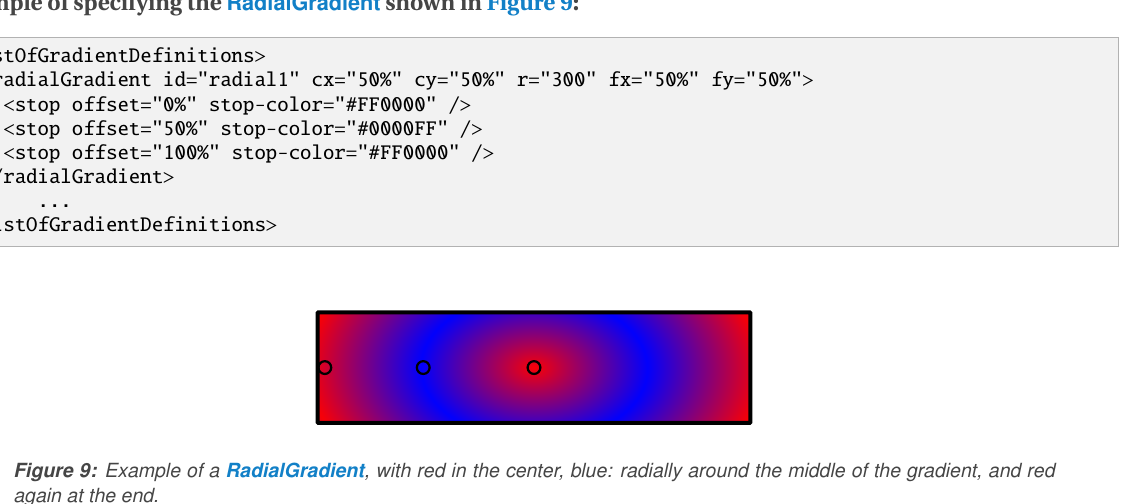
Figure 9: Example of a RadialGradient , with red in the center, blue: radially around the middle of the gradient, and red again at the